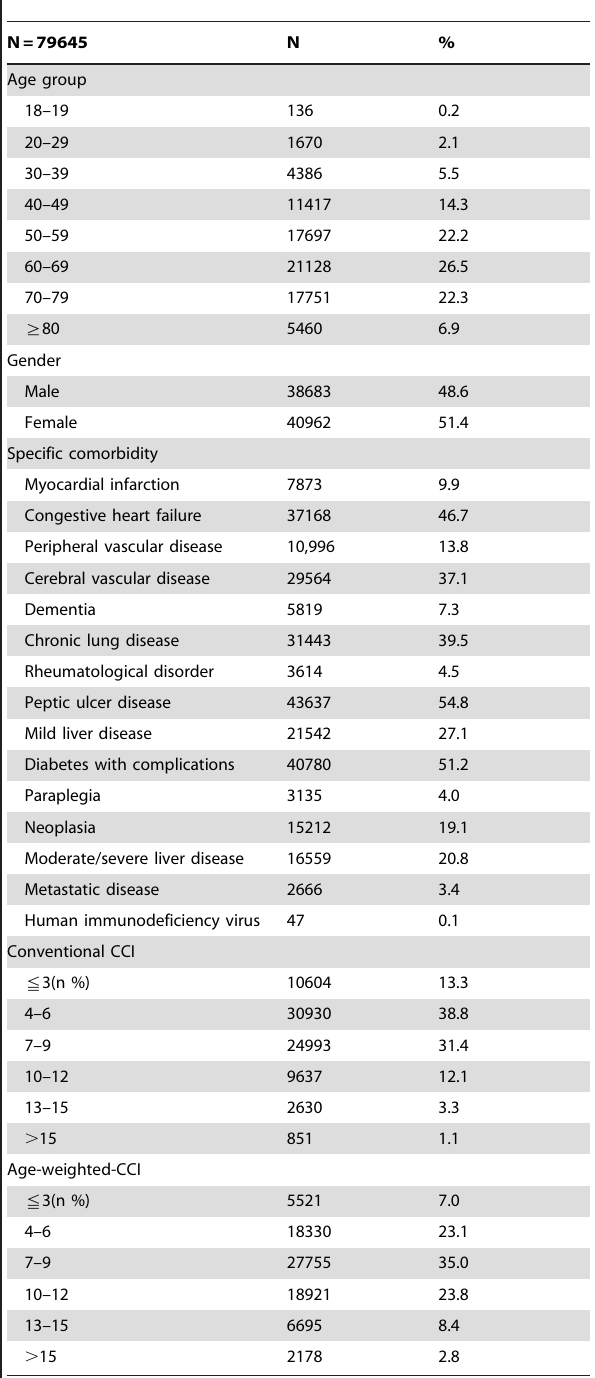
Table 1. Basic demographics and characteristics of incident dialysis patients.